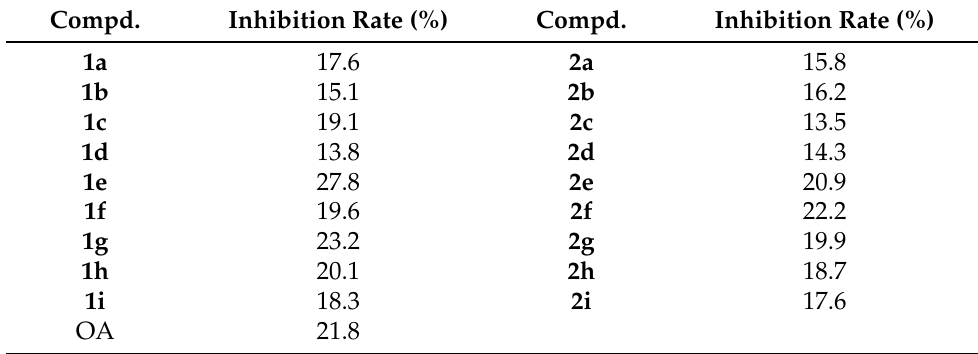
Table 3. Enzyme-inhibition Rate of Compounds 1 and 2 at 0.35